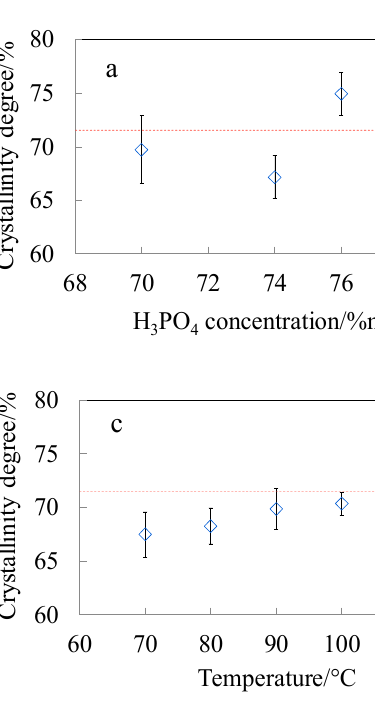
Figure 7. Crystallinity degree determined by deconvolution of WAXD patterns of ( a ) CNC_P series hydrolysed in phosphoric acid solutions at different concentrations; as well as CNC succinylated at different ( b ) SA:OH molar ratios; ( c ) temperature and ( d ) time. Dashed line depicts the crystallinity index of Avicel_Raw material.